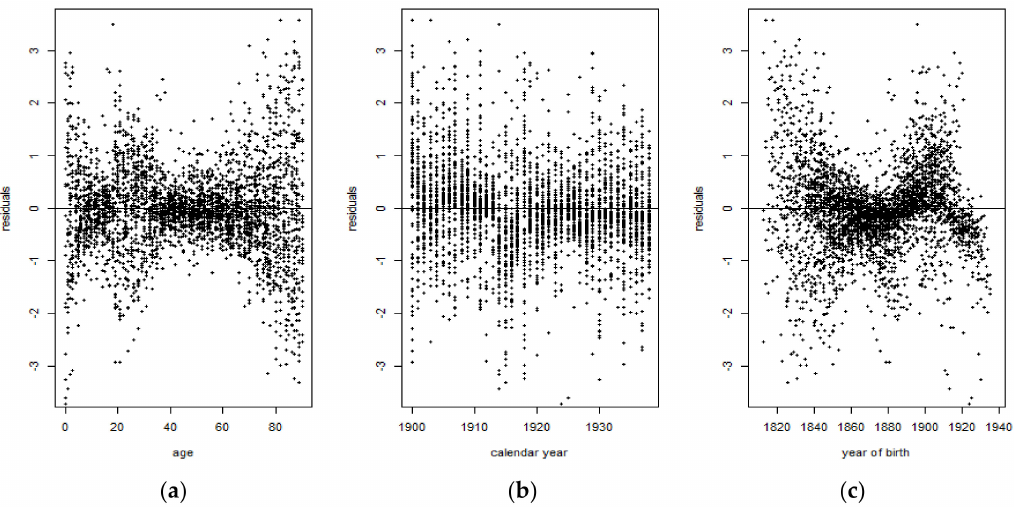
Figure 14. Lee-Carter residuals plotted against ( a ) age, ( b ) calendar year, and ( c ) year of birth for the 1900–1938 period.